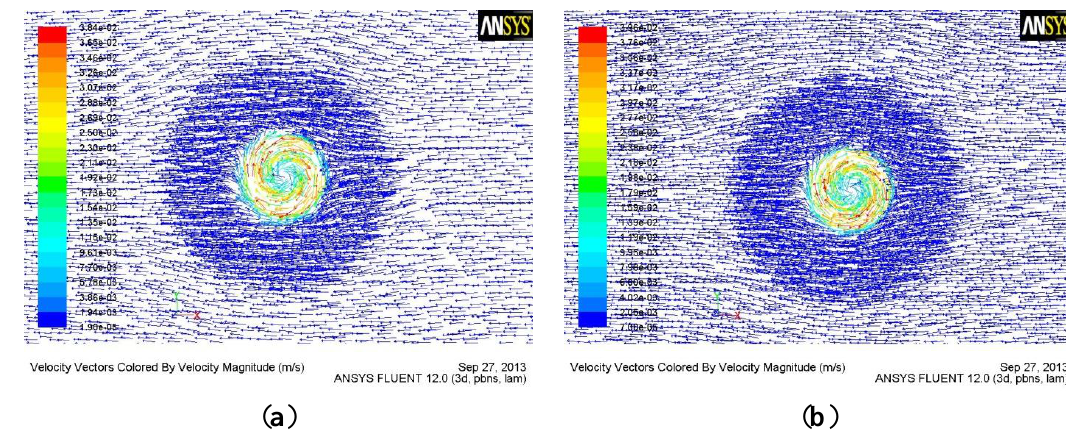
Figure 7. ( a ) Flow field at section c by the conventional tool; ( b ) Flow field at section c by the tool with the half-screw